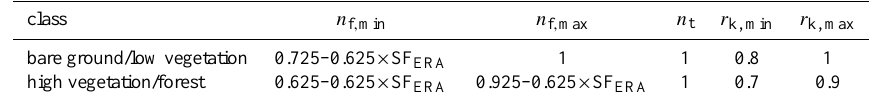
Table 1. Intervals of input parameters assumed in the TTOP modeling. SF ERA : average yearly snowfall from ERA-interim reanalysis in m of water equivalent.